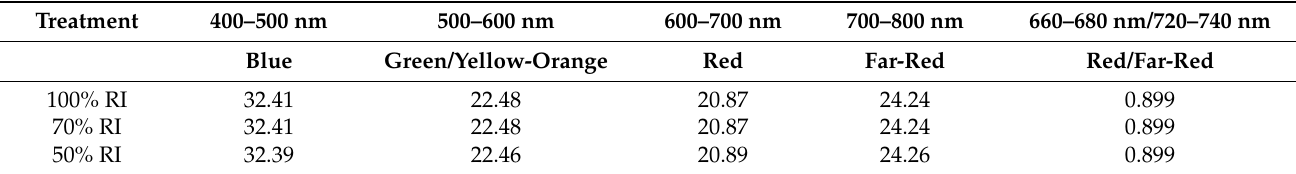
Table 3. The proportion of different light wavelength ranges in the light treatments.